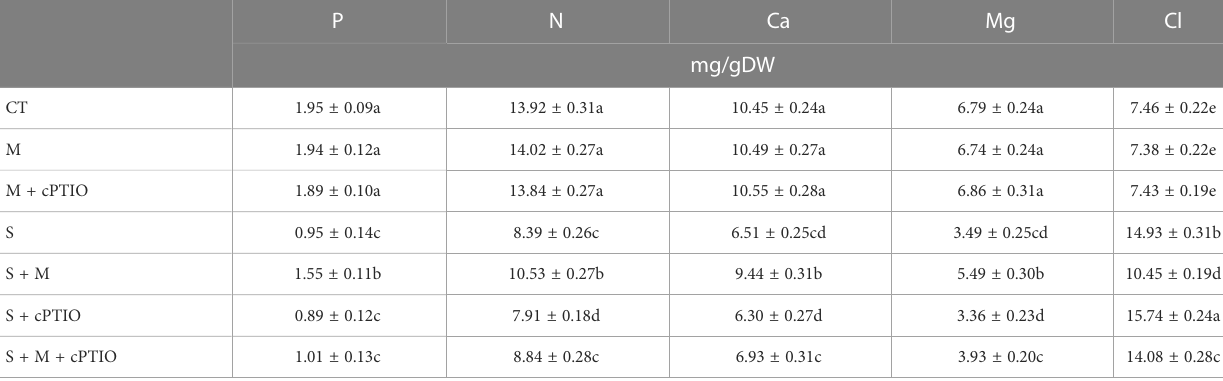
TABLE 2 The leaf concentration of mineral nutrients in tomato seedlings treated with melatonin (150 m M) and cPTIO (100 m M) under NaCl (150 mM) treatment. P N